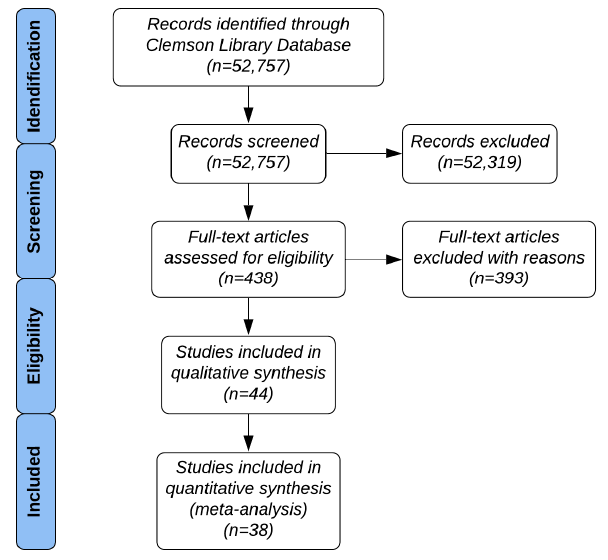
Figure 1. Preferred Reporting Items for Systematic Reviews and Meta-Analyses (PRISMA) flow chart used to conduct the systematic literature review [31].